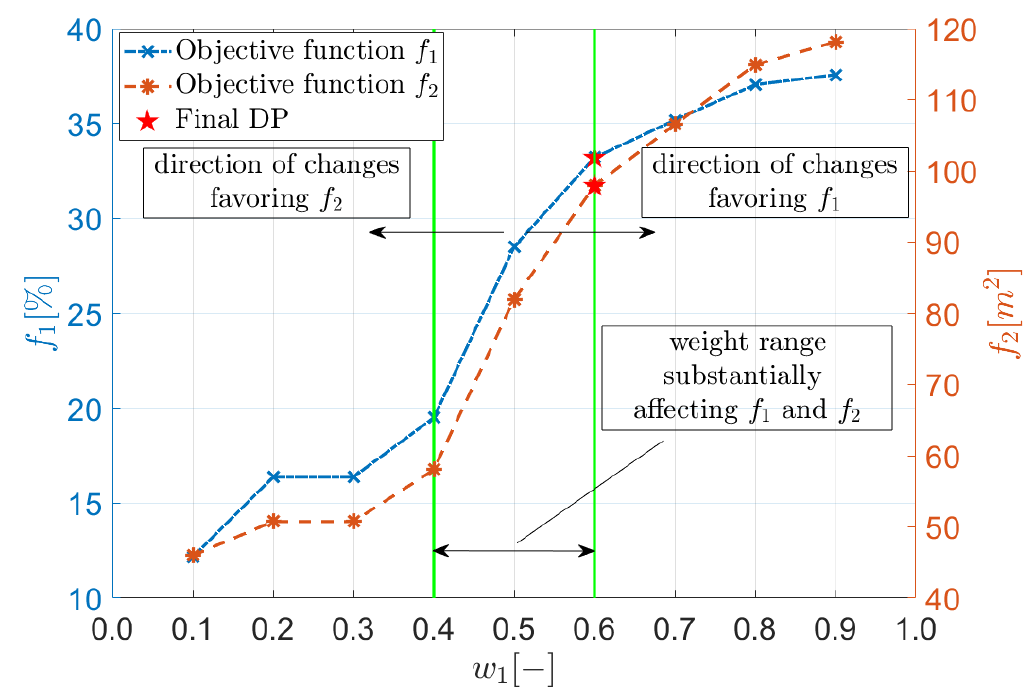
Figure 12. Sensitivity analysis of criteria with respect to weight distributions.